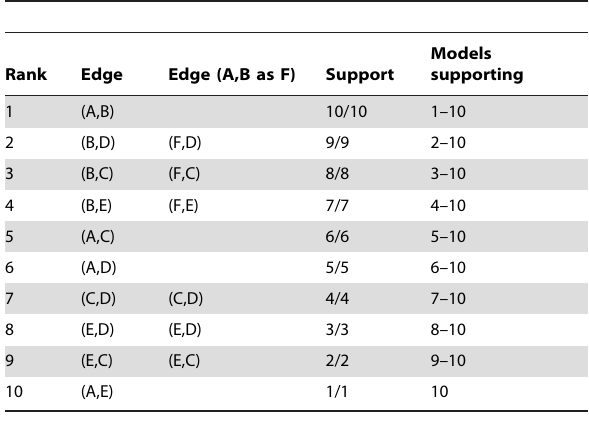
The lower the rank of an edge, and the higher its support, the stronger is the dependence between the pair of editing sites (see text for details). The third column is the same as the second column, except that either A or B are marked as F. The rightmost column lists the models in which this edge appears. (Supplementary Figure S4b). Using AIC scores produced only a single difference, in model M 8 . The edge (C,D), which is present in the BIC and Bayes scores, was replaced by the edge (E,C) for the AIC score (Supplementary Figures S4a and S5). However, as we